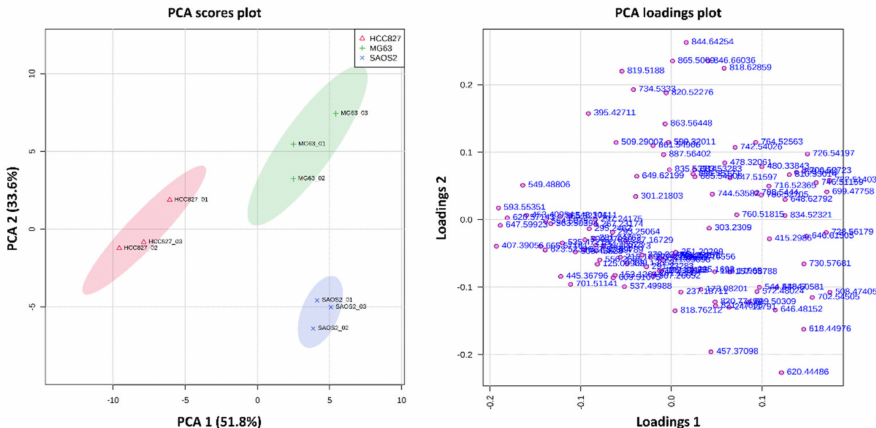
Figure 2. PCA scores and loadings plot show separation of the MG63 and SAOS-2 aggregoid models from the HCC827 aggregoid model. Principal components, PC 1 (51.8%) and PC 2 (33.6%) showed the best separation between sample groups. The discriminatory m / z values of interest were distributed separately from the cluster of peaks. Samples were grouped with 95% confidence, HCC827 (red), MG63 (green), and SAOS-2